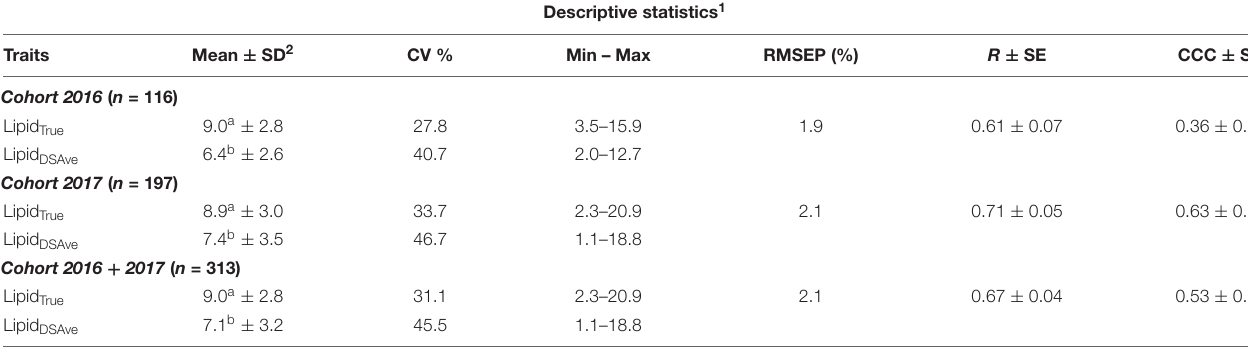
TABLE 1 | Descriptive statistics and phenotypic (dis)agreement for lipid content traits recorded on European